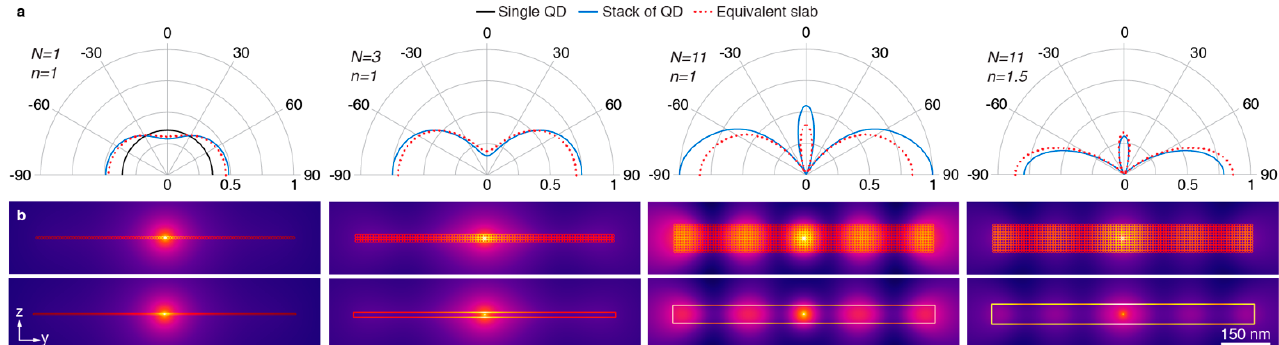
Figure 4. Simulated effective thickness of SNPs arranged in a monolayer. Effective thickness as a function of dielectric contrast ε m / ε p and interparticle spacing d gap for square ( a ) and triangular ( b ) lattice arrangement.